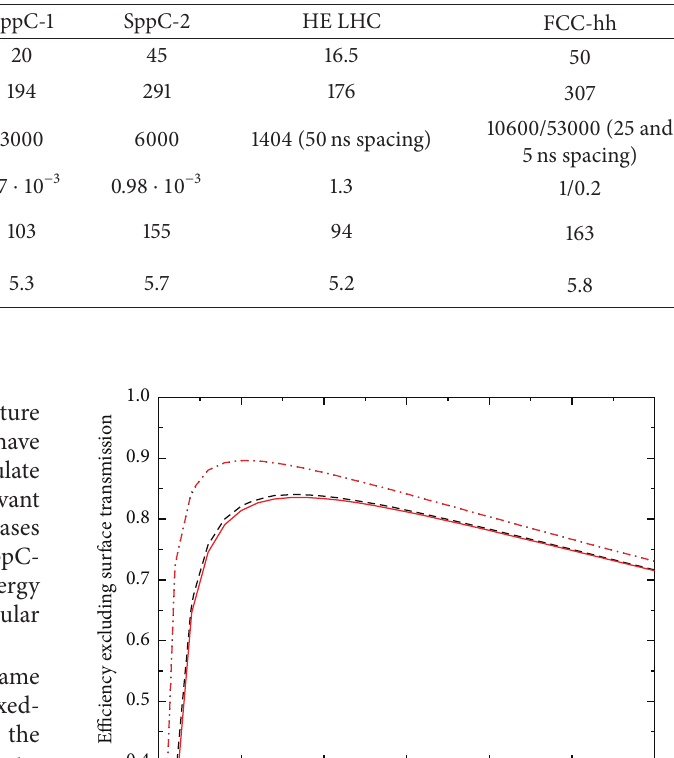
Table 1: Beam parameters for the proposed next-generation colliders and the corresponding fixed-target energies along with the boost ( 𝛾 lab c . m . s . ) and the rapidity shift ( Δ𝑦 lab c . m . s . ) between the centre-of-mass frame of the fixed-target collision and the laboratory frame, which identifies to the centre-of-mass frame in the collider mode.